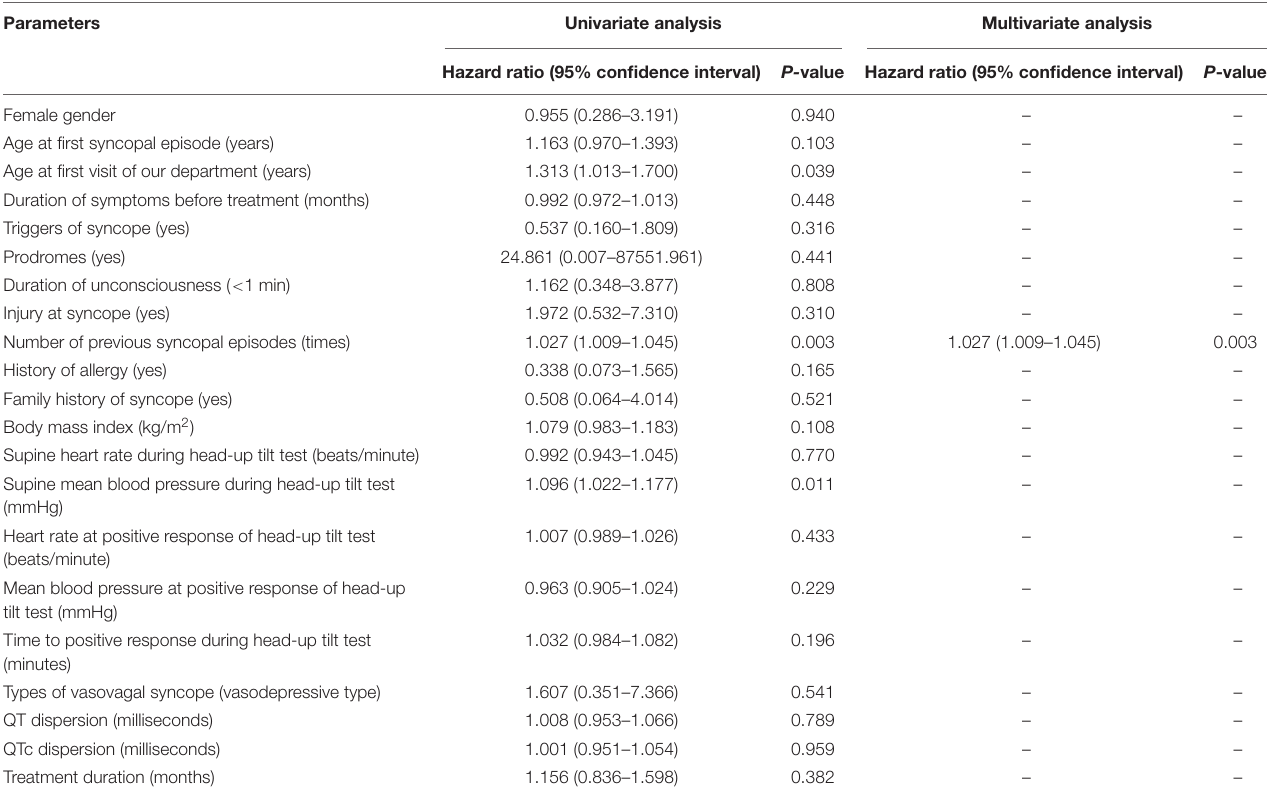
TABLE 2 | Risk factors for syncopal recurrence from Cox regression analyses. Parameters